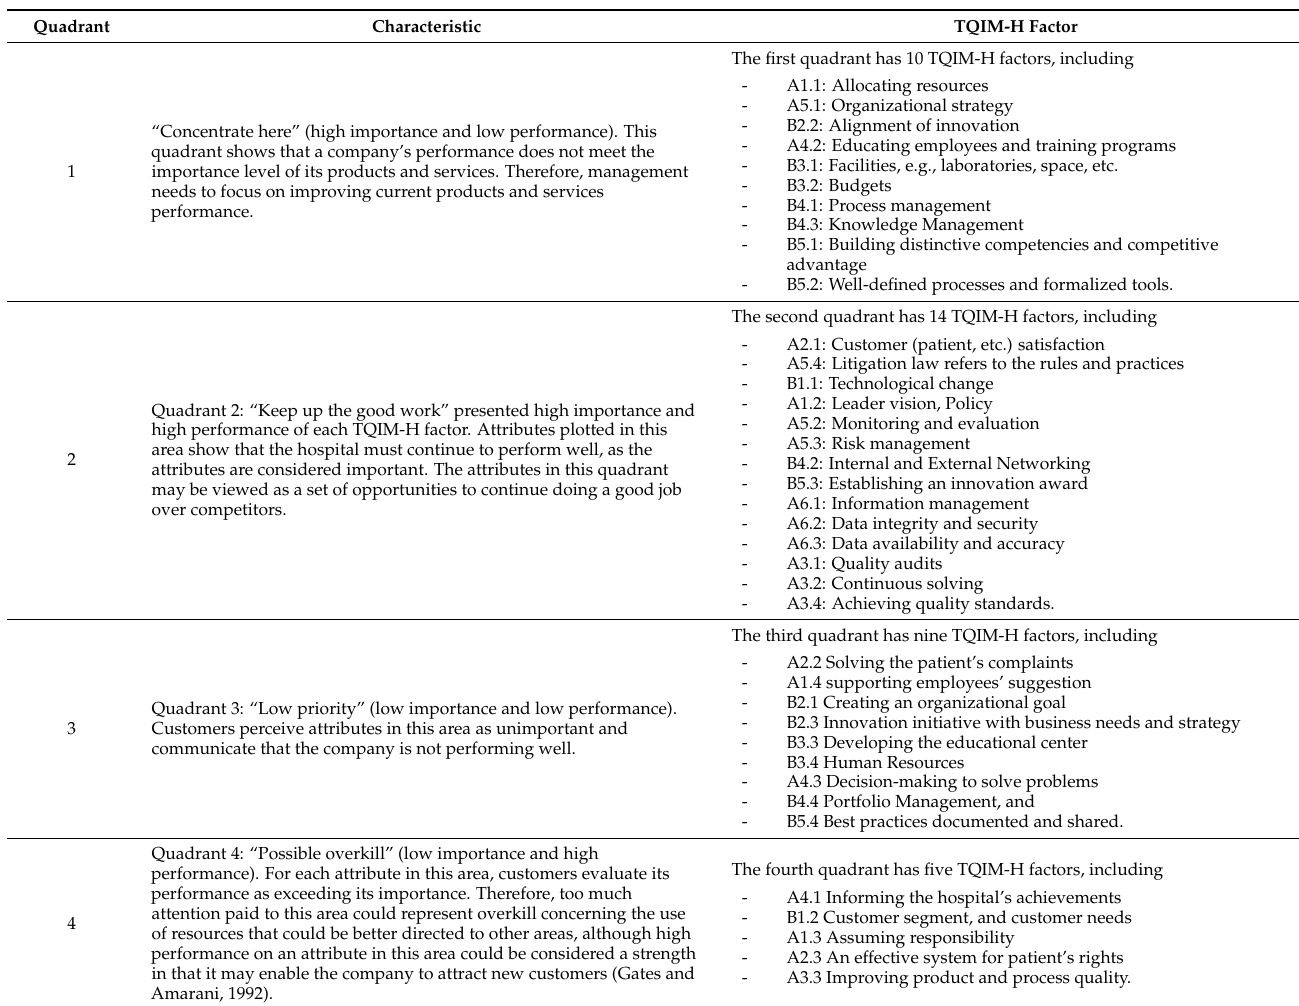
Figure 4. IPA of total quality and innovation management in the hospital. Table 4. TQIM-H with IPA analysis .